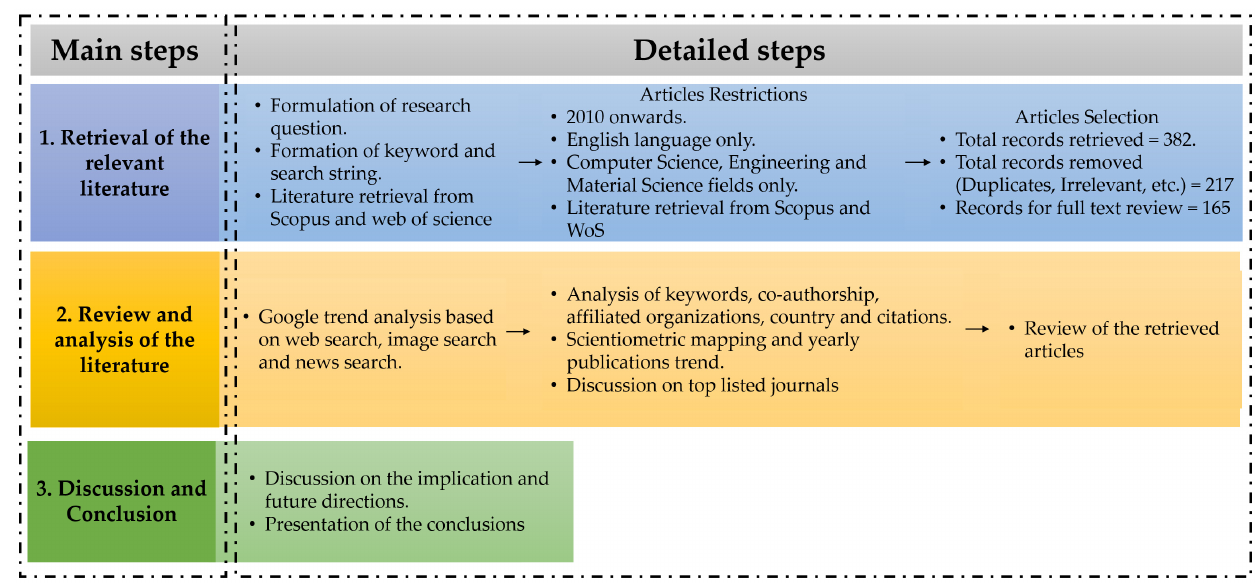
Figure 1. Representation of the output of the deep learning model.